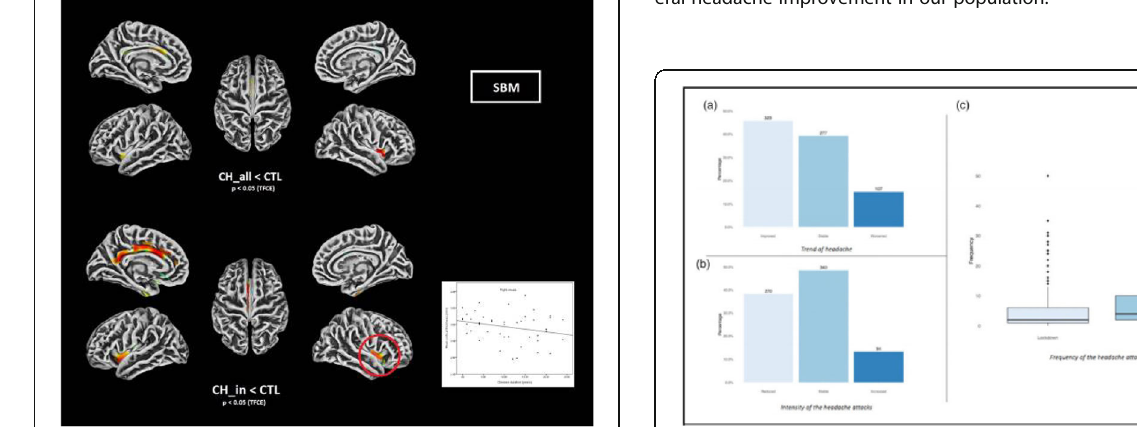
Fig. 1 (abstract AL07). See text for description